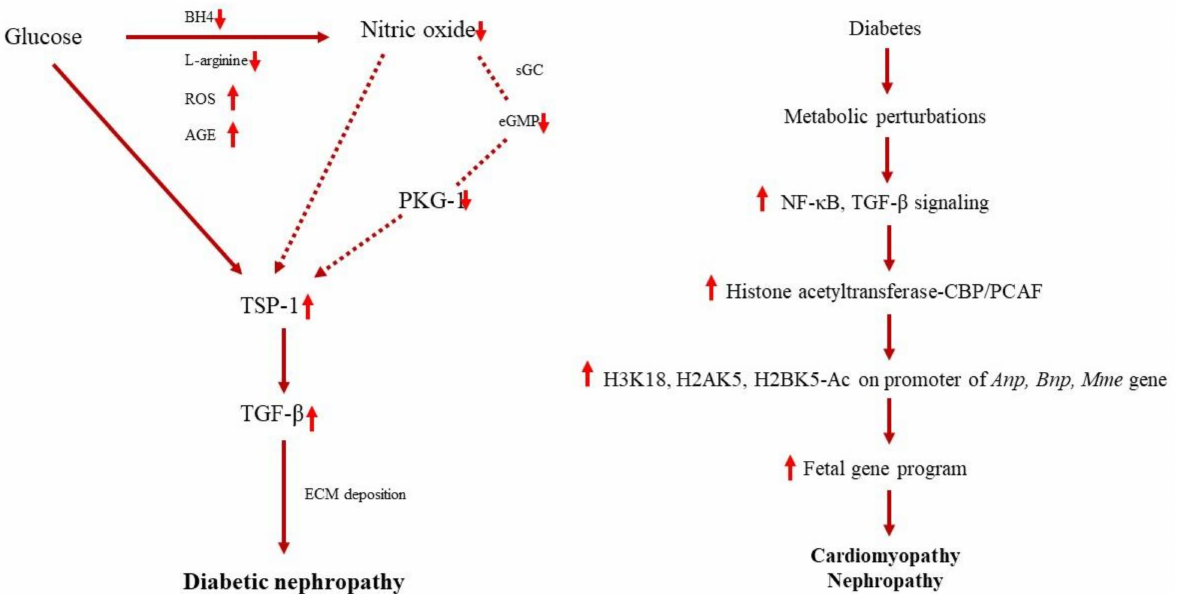
Figure 3. Schematic diagram representing the development of diabetic nephropathy, cardiomyopathy and nephropathy (adapted from